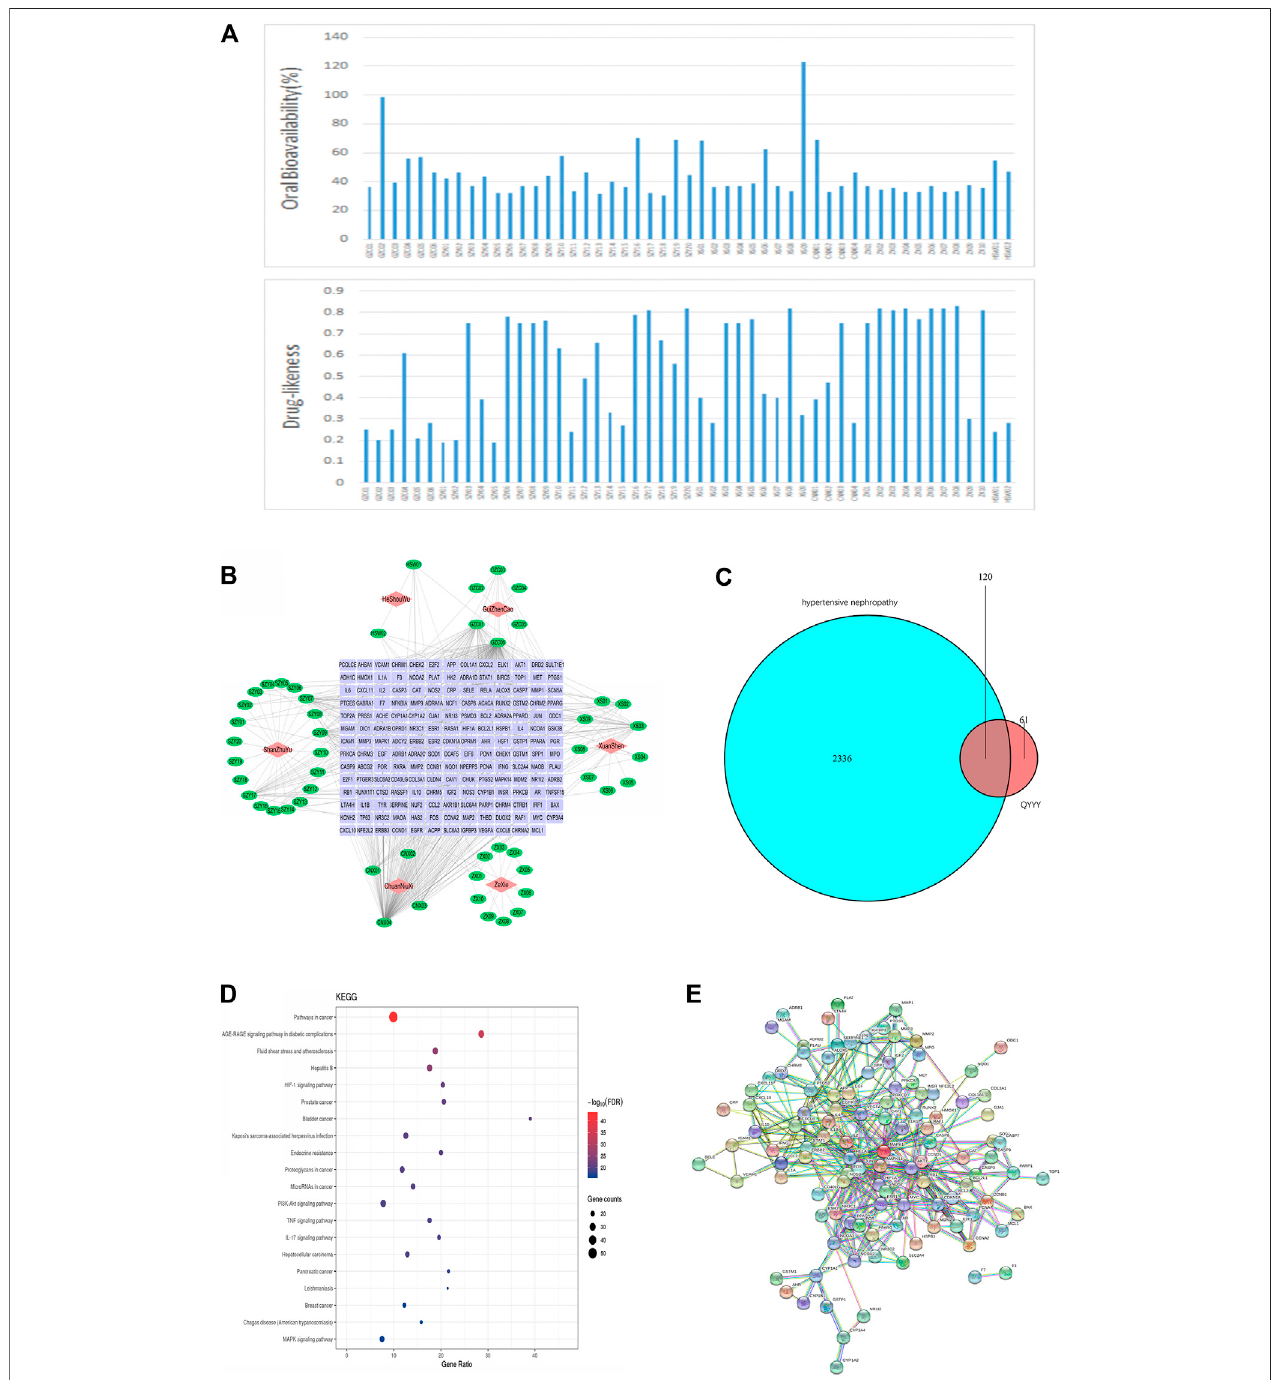
FIGURE 2 | Network pharmacology prediction of the potential active compounds in QYYY and corresponding pathways related to hypertensive nephropathy. (A) Active compounds in QYYY with oral bioavailability (OB) ≥ 30% and drug-likeness (DL) ≥ 0.18. (B) Drug – Compound – Target Network: the nodes represent drug (red diamond),candidatecompounds(greenellipse),andthetargetsproteins(purplerectangle). (C) Venndiagramof2,456hypertensionnephropathy-associatedgenesand181 putative target proteins screened from candidate compounds of QYYY. (D) KEGG analysis of the 120 gene targets. (E) PPI network of the 120 gene targets.